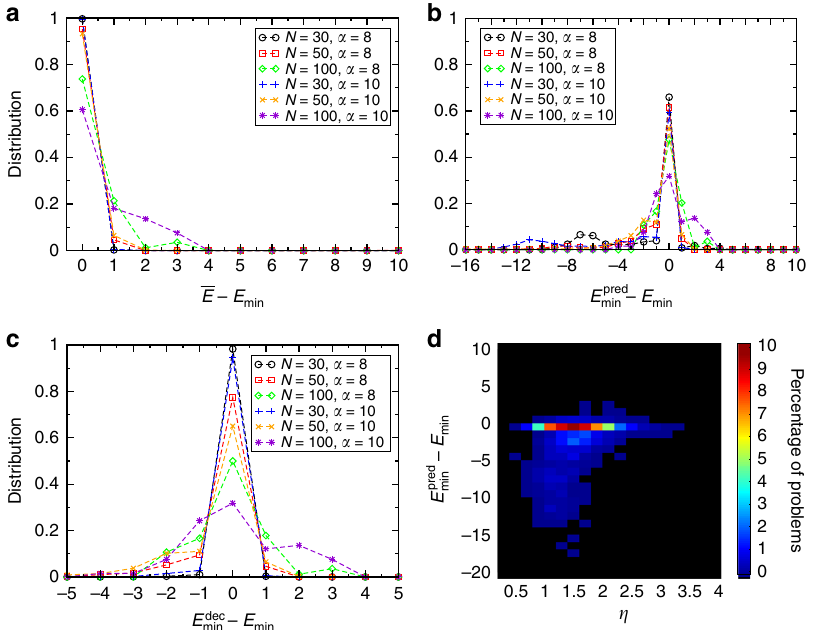
Fig. 3 Algorithm statistics over random Max 3-SAT problems. Distribution of differences between the real global minimum E min obtained with the exact algorithm MaxSatz and a the smallest energy found by the algorithm E , b the predicted minimum value E pred shown for problems with different N and α values (see legends). d The percentage of instances indicated by color (see color bar) for different values of the E error E pred and hardness η . Most instances are in the E pred min min (cid:2) and are dominantly